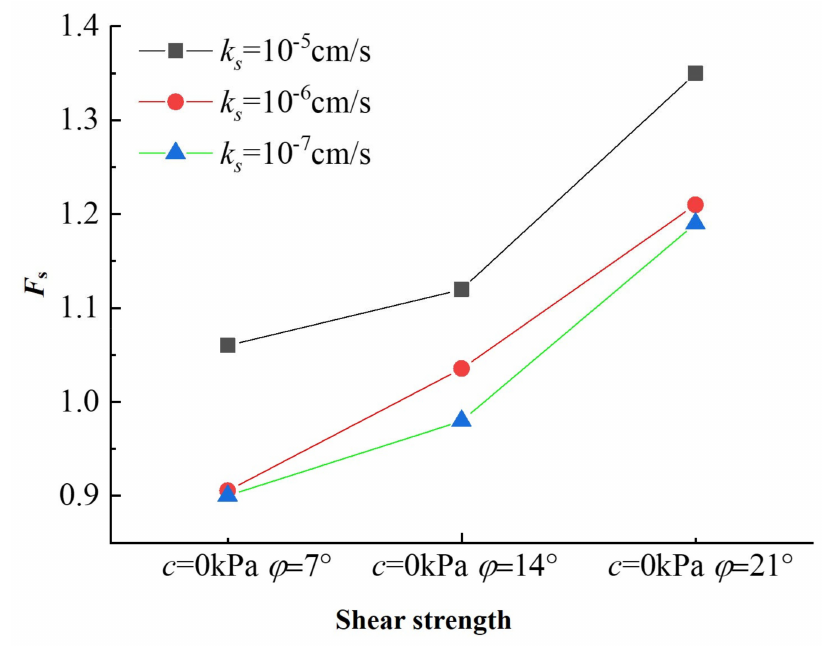
Figure 14. Influence of strength of intermediate cover on landfill